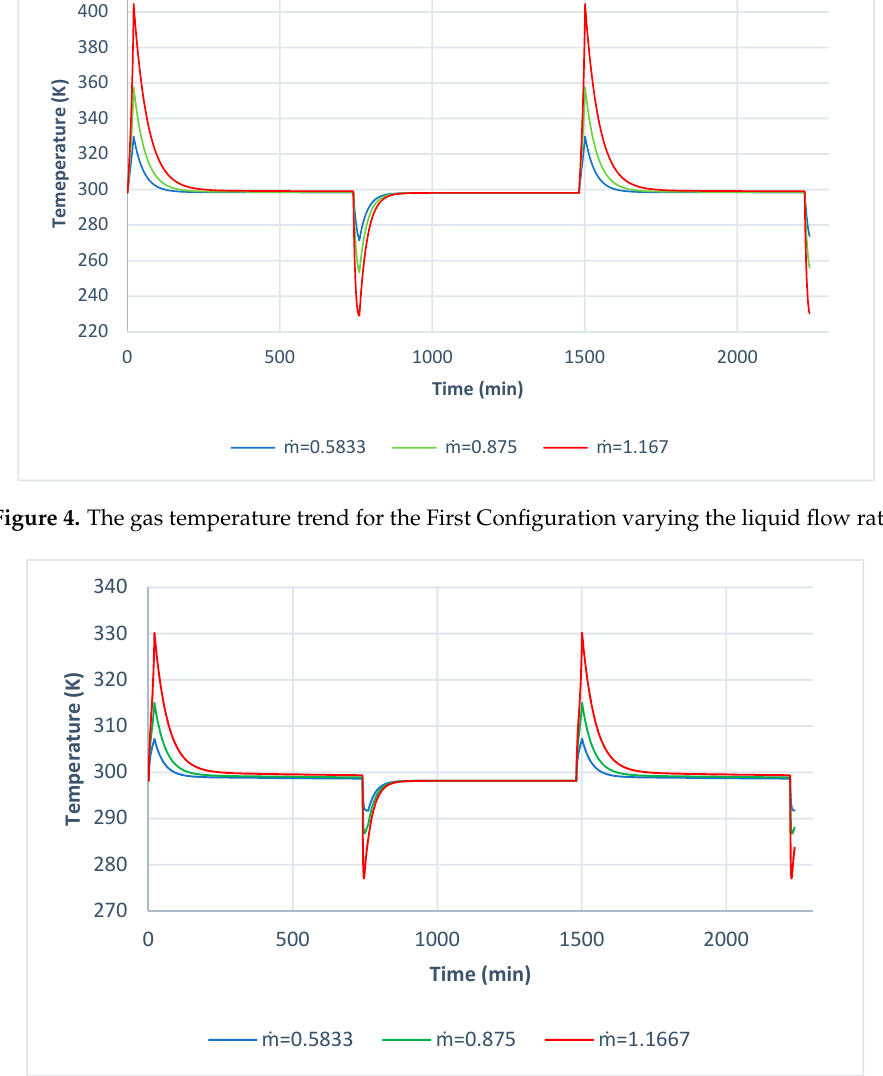
Figure 6. Pressure gas trend for the First Configuration varying the liquid flow rate. Figure 7. Pressure gas trend for the Second Configuration varying the liquid flow rate.